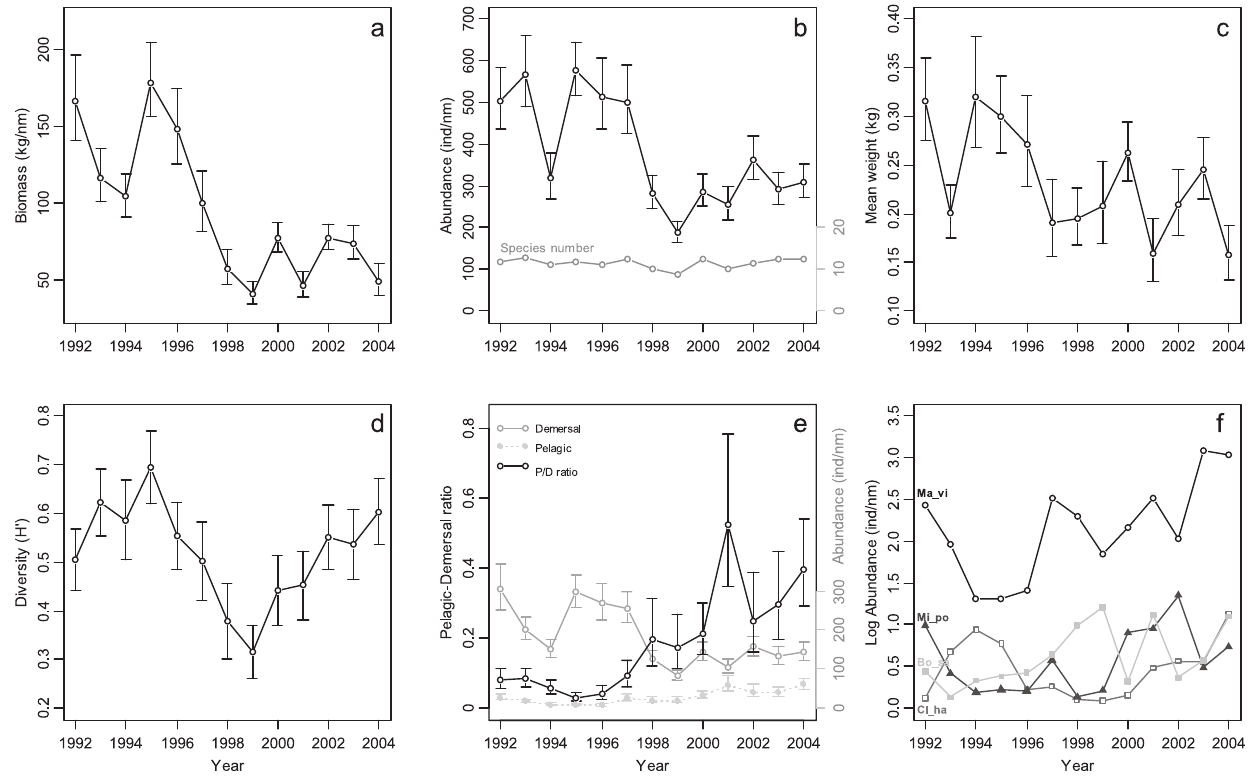
Figure 2. Fish community parameters for each year 1992 2 2004. The mean biomass ( a ), mean abundance and (with scale on right) species number ( b ), mean weight of individual fish ( c ), Shannon–Weaver diversity ( H’ ) ( d ), the mean P/D ratio and (with scale in the right) pelagic and demersal fish abundances ( e ), and mean log-transformed abundance of four pelagic species ( f ) Mallotus villosus (circles), Boreogadus saida (solid gray squares), Micromesistius poutassou (triangles) and Clupea harengus (open squares). The 95% confidence intervals for the means are shown in most cases based on the log-transformed data after reweighting to be representative of the sampling regions. doi:10.1371/journal.pone.0062748.g002 PLOS ONE |